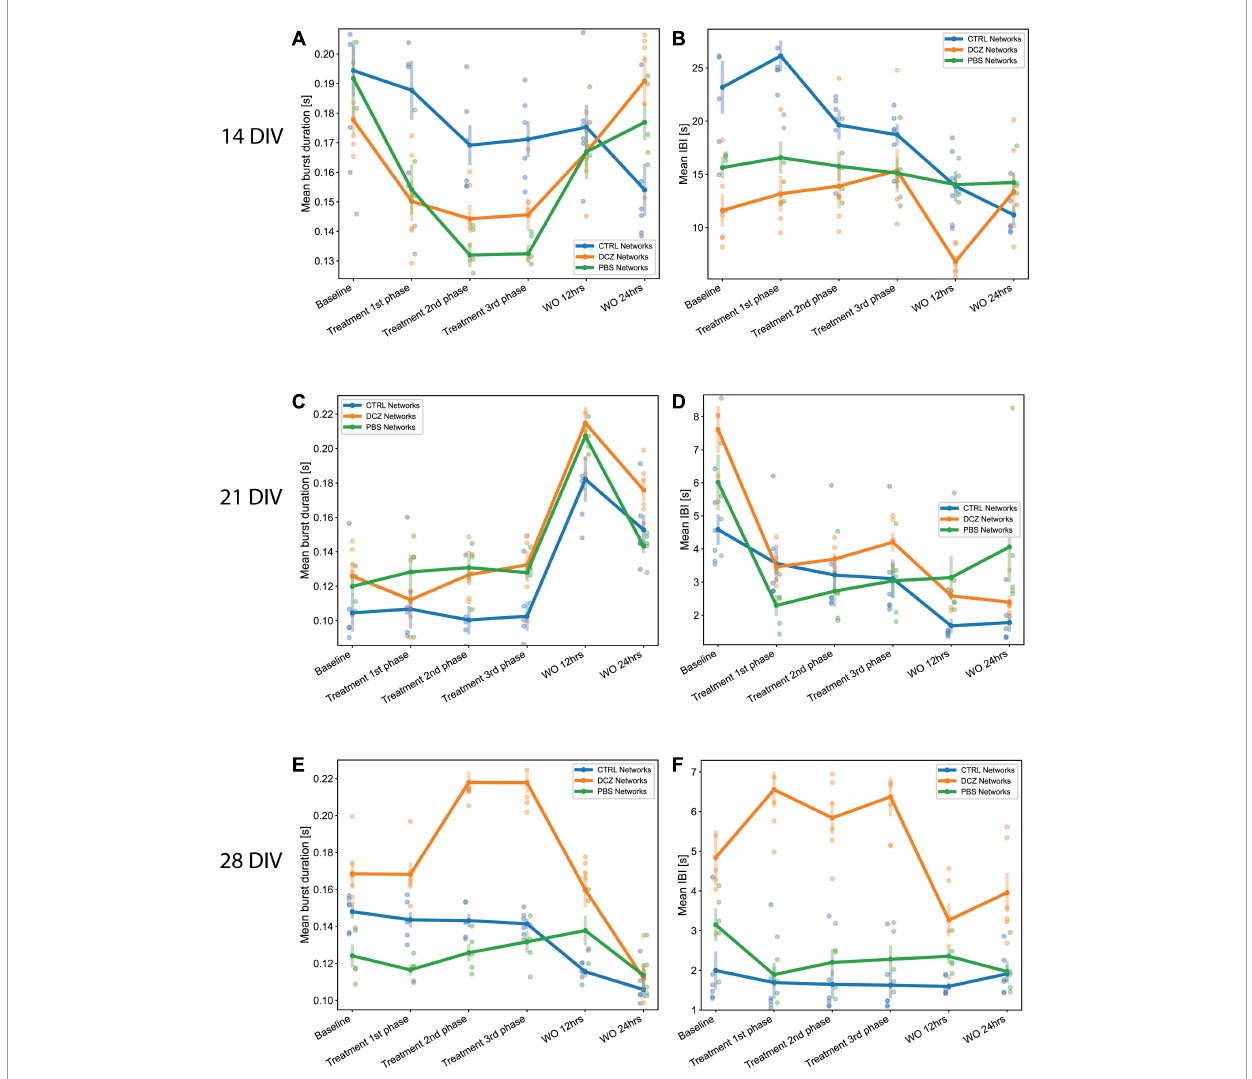
FIGURE7 Neural network mean burst duration and mean inter burst intervals. (A,C,E) Plots showing the mean burst duration and (B,D,F) showing the mean IBIs for each network group ( n = 6 for CTRL and DCZ, and n = 5 for PBS) across the baseline, treatment and recovery recordings at 14, 21, and 28 DIV. The solid lines and solid circles plot the mean values for all networks in one group, the shaded bars show the standard error of the mean, and the shaded circles show the individual data